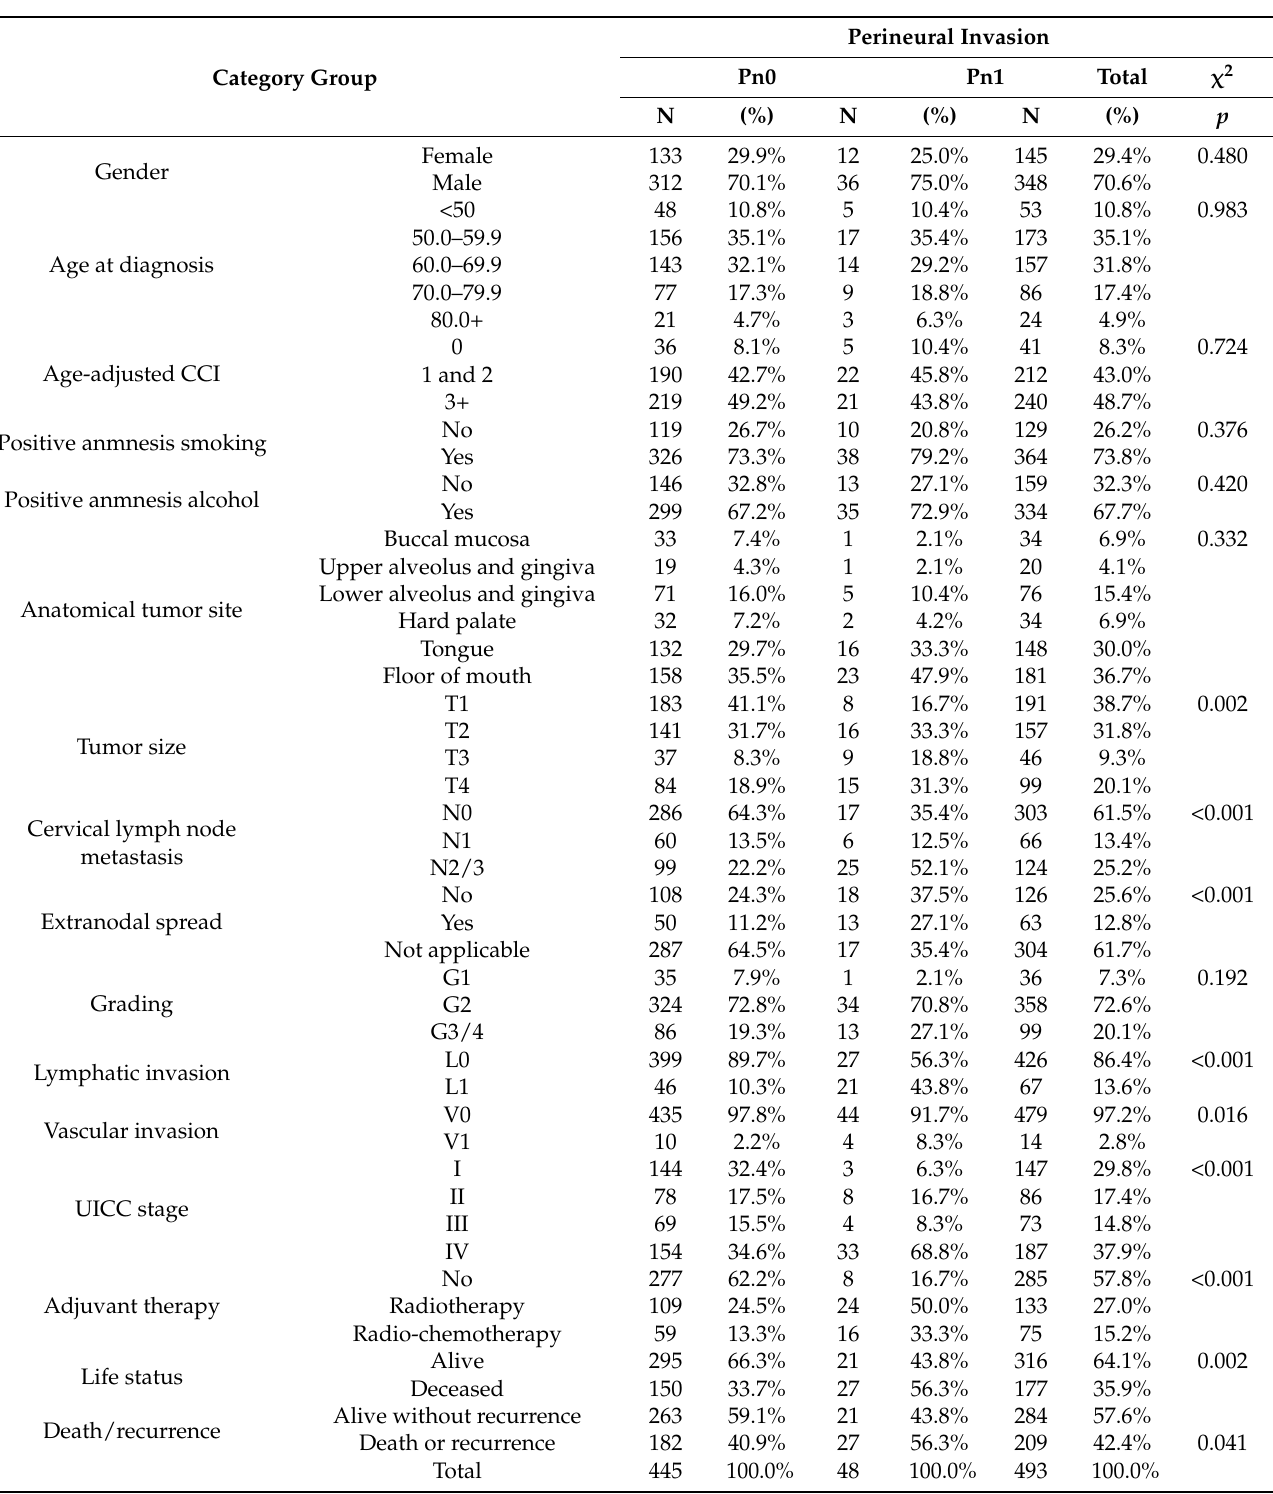
Table 1. Clinicopathological characteristics of OSCC patients according to the diagnosis of PNI ( n =